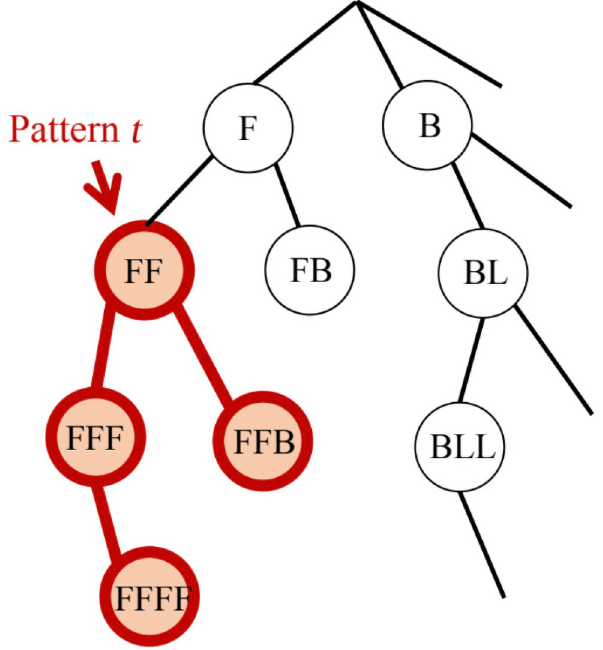
Fig 1. SPP pruning. One of the mechanisms of SPP identifies and removes patterns that do not contribute to the model before performing the optimization. For example, if pattern t does not satisfy the pruning criterion specified in [34], the sub-tree below pattern t is deleted.